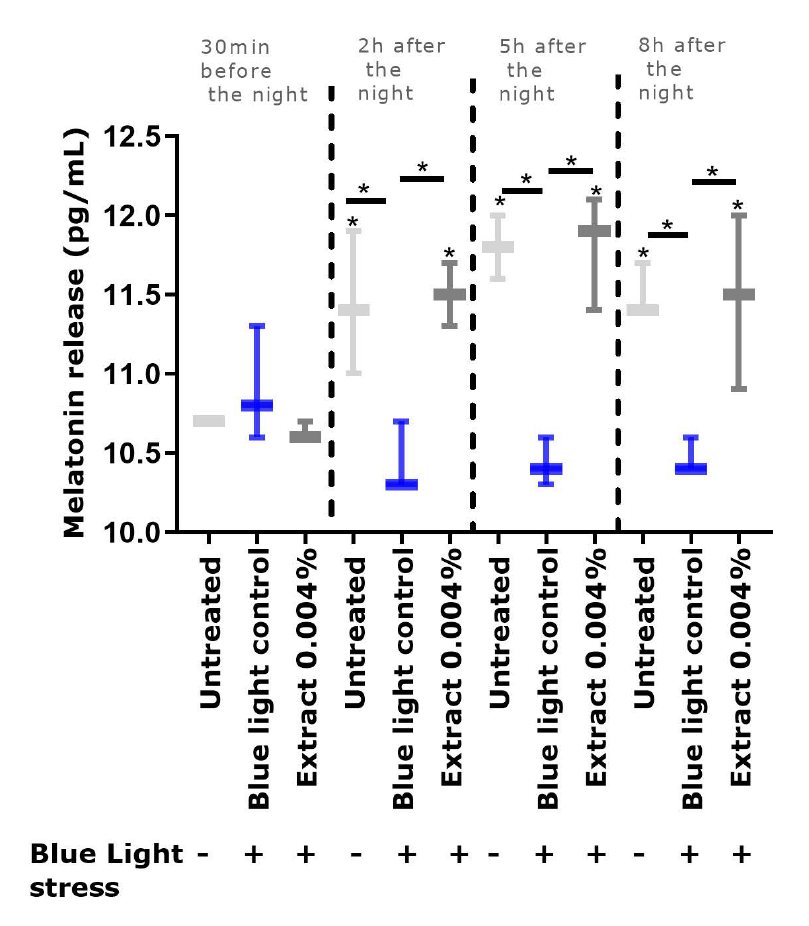
Figure 6. Quantification of melatonin release in the co-culture medium at day 1 in cells exposed or not exposed to blue light stress (20 mJ/cm 2 ) and treated or not treated with the extract. Statistical analysis with a Kruskal–Wallis ANOVA, followed by a Mann–Whitney U test, in comparison with the blue light control, where * p <